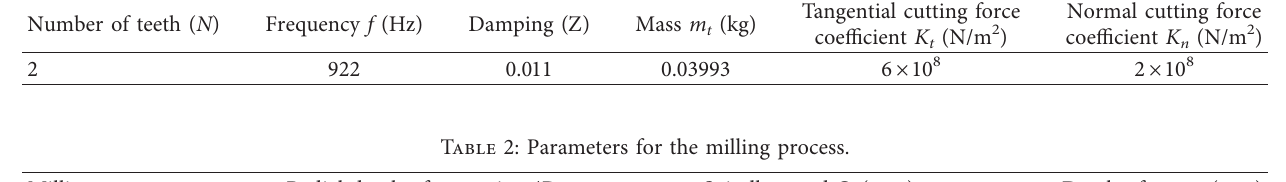
Table 1: Modal parameters.